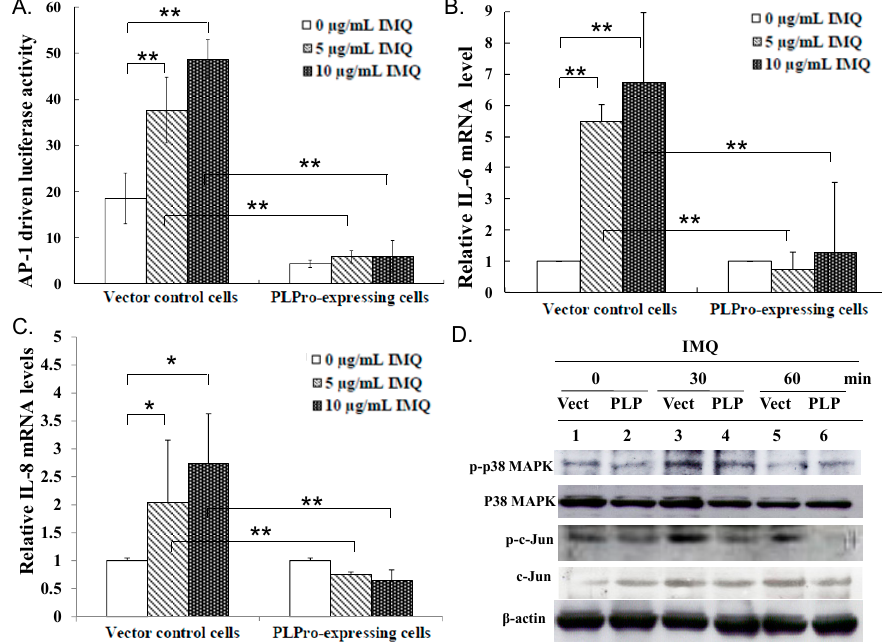
Figure 4. Detection of IMQ-induced AP-1-mediated production of IL-6 and IL-8 in the vector control and PLPro-expressing cells. AP-1-driven firefly luciferase activity was normalized by Renilla luciferase activity ( A ). Relative mRNA levels of IL-6 ( B ) and IL-8 ( C ) were normalized by GAPDH mRNA, presented as a relative ratio. In addition, the activated status of p38 MAPK and AP-1 was examined using Western blot with anti-phospho-p38 MAPK and anti-phospho-c-Jun antibodies ( D ). * p -Value < 0.05; ** p -value < 0.01 by Student’s t -test.